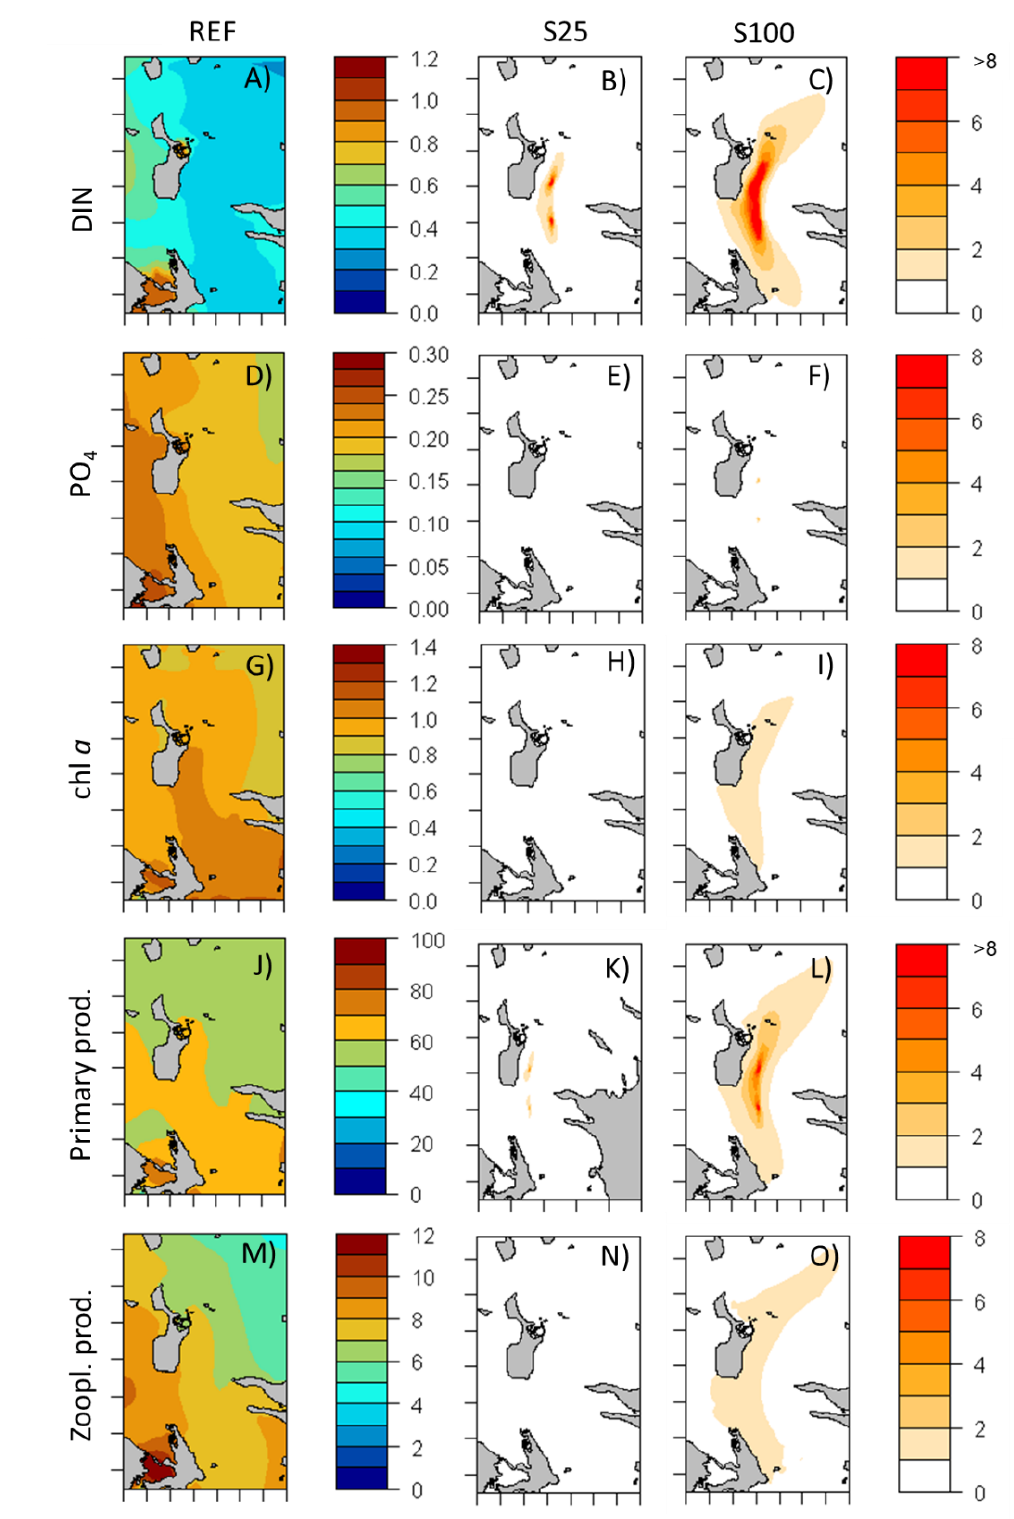
Fig. 8. (A,D,G,J,M) Average values (June to July 2009) for (A) dissolved inorganic nitrogen (DIN) (mmol m −3 ), (D) PO 4 (mmol m −3 ), (G) chl a (mg m −3 ), (J) primary production (mg C m −3 d −1 ) and (M) zooplankton production (mg C m −3 d −1 ) and the respec- tive percent difference (B,E,H,K,N) between Scenario 25 (S25) and reference run (REF) and (C,F,I,L,O) between Scenario 100 (S100) and REF at 5 to 6 m